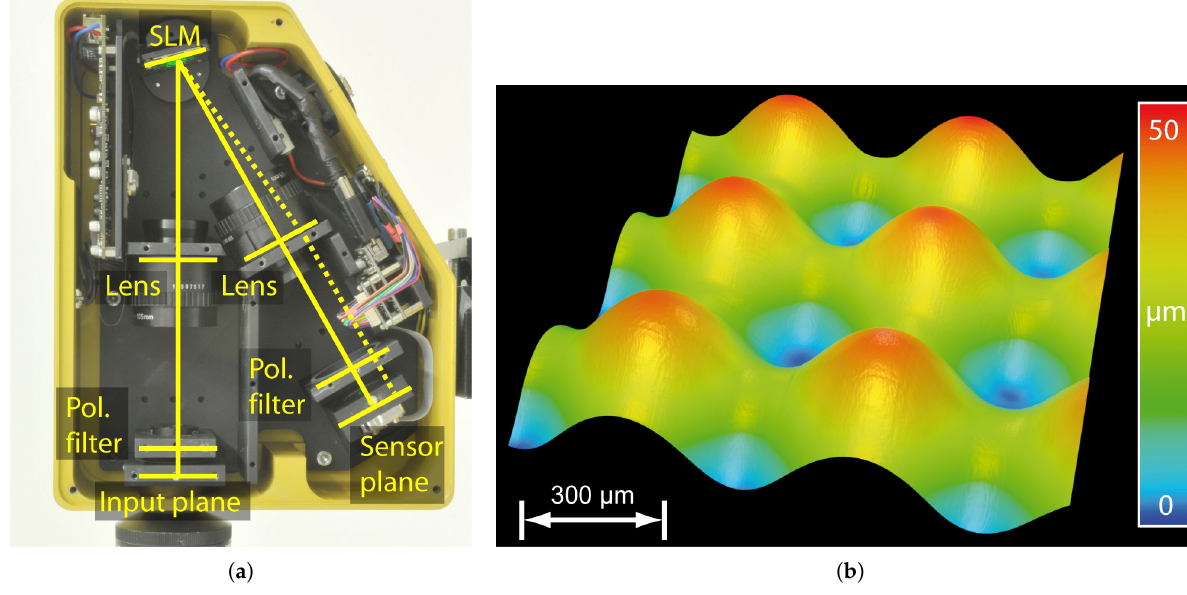
Figure 5. Computational Shear Interferometry: ( a ) Commercially available shear interferometer Golden Eye , which creates the shear using a liquid crystal SLM in the Fourier plane of a 4 f -configuration. The interferometer can be attached to any imaging optics and measures with interferometric precision while being insensitive against mechanical vibrations. ( b ) Measured shape of a micro lens array using CoSI in transmission. The system measures relatively steep slopes with a measurement uncertainty of σ = 2.5 nm. For more details, please refer to the